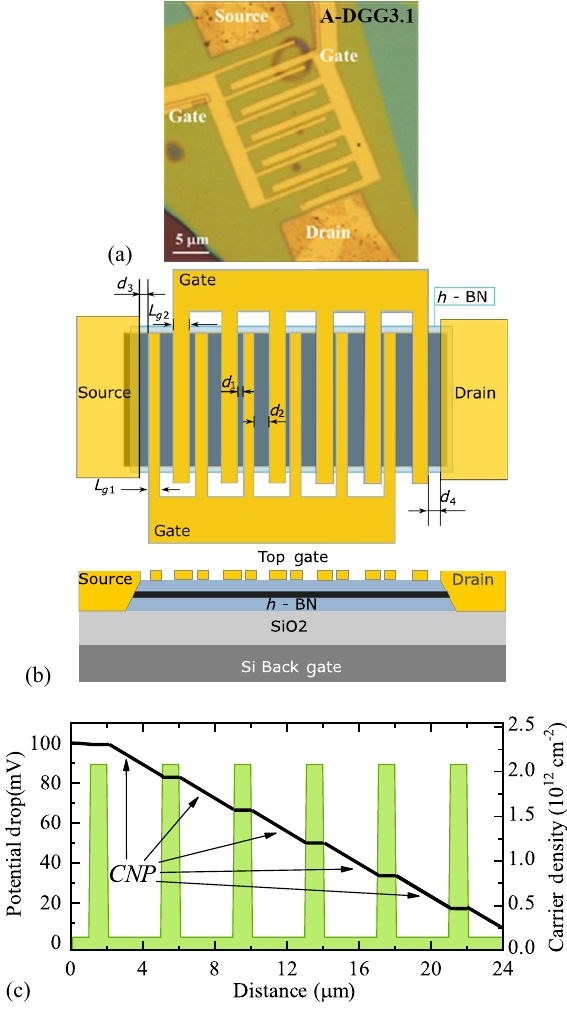
FIG. 1. The microphoto of the A-DGG3.1 sample (a), sche- matic top and cross-sectional device images illustrating the h -BN/ graphene/ h -BN heterostructure including the asymmetric dual grating-gate metallization (b), and the gate-controlled charge density distribution (green area) together with potential distribu- tion along the channel (black solid line)